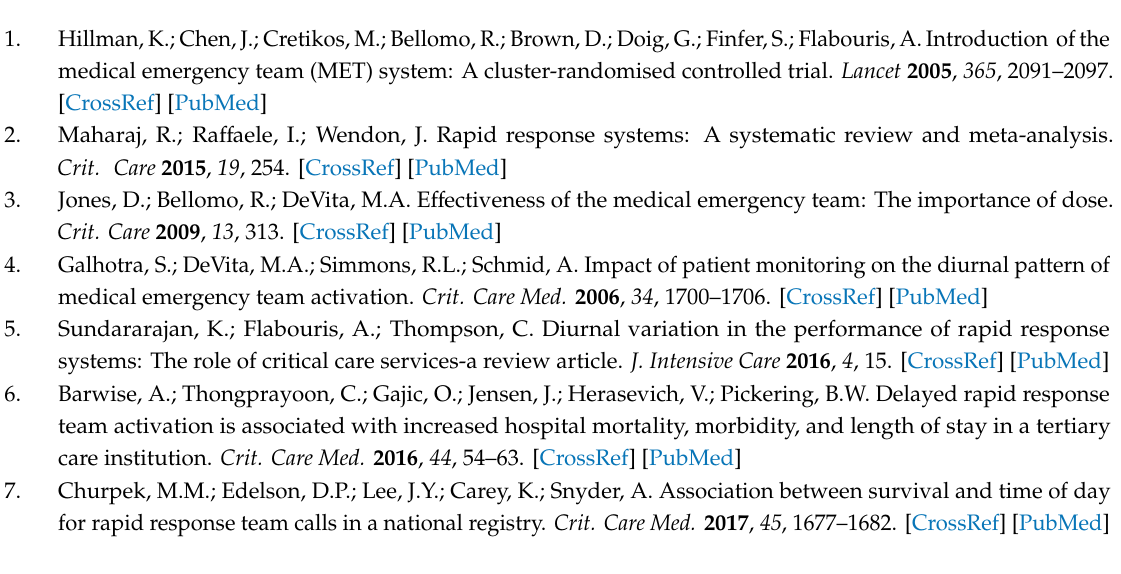
Table S1: Criteria for medical alert team activation, Table S2: Modified early weaning score (MEWS) Table S3: Baseline patients and event characteristics, Table S4: The multivariate analysis for the risk factors associated with ICU admission and 28-day mortality after RRT